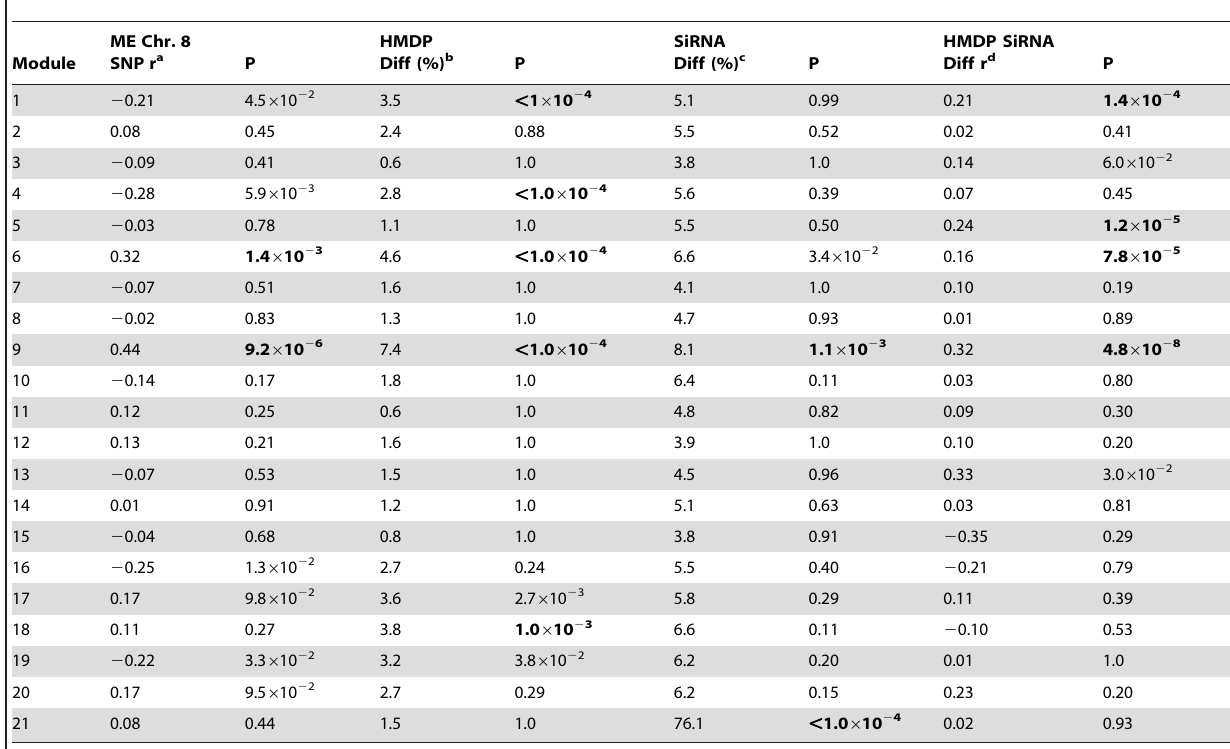
Table 4. Sfrp1 knockdown in primary calvarial osteoblasts preferentially alters the expression of module 9 genes.